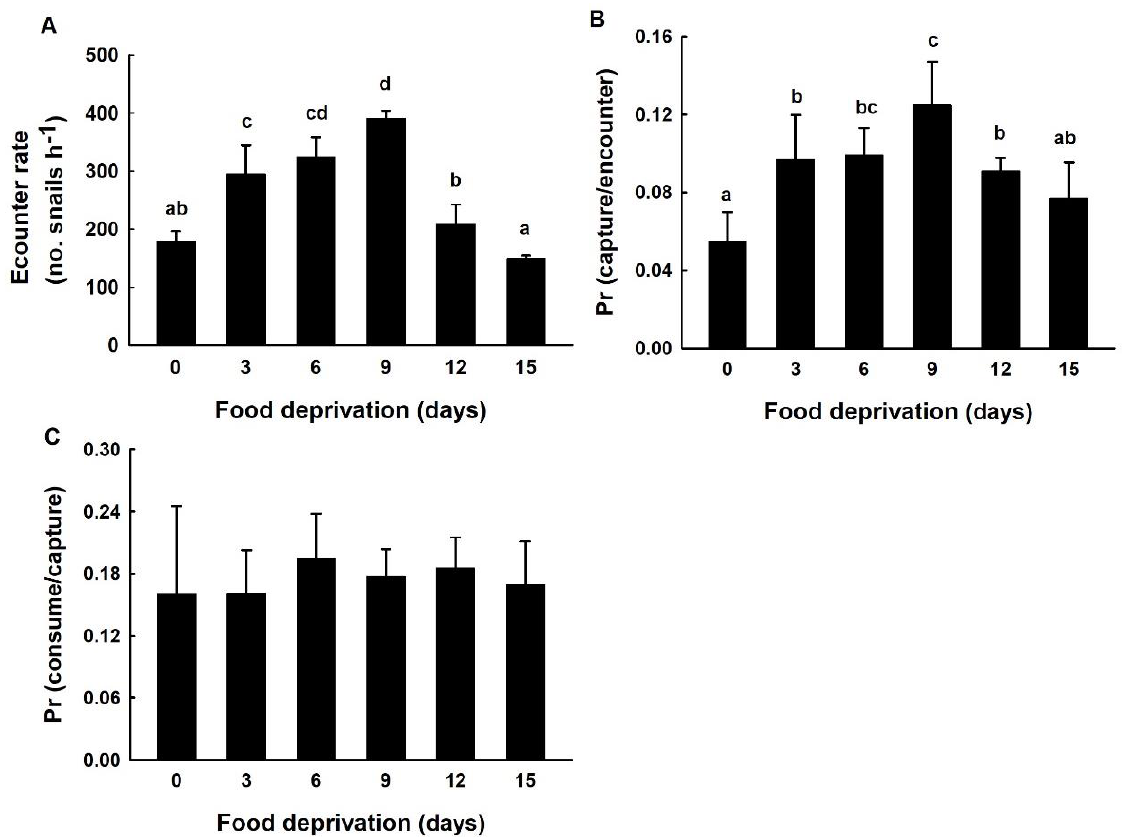
Figure 4. Changes of ( A ) the encounter rate, ( B ) the probability of capture upon encounter, and ( C ) the probability of consumption upon capture under different degrees of food deprivation in E. sinensis . Lowercase letters indicate significant differences among treatments ( p ≤ 0.05 ).